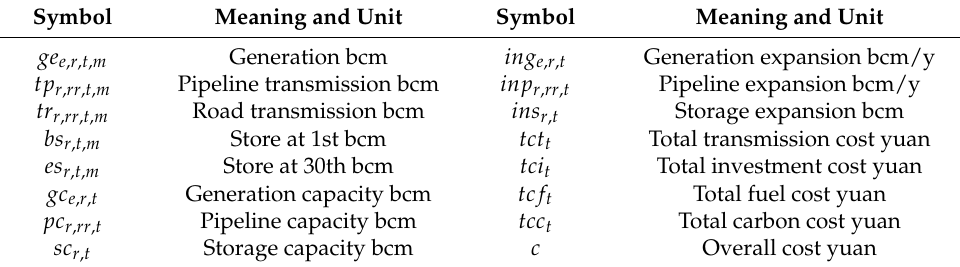
Table A3. Nomenclature: Variables.